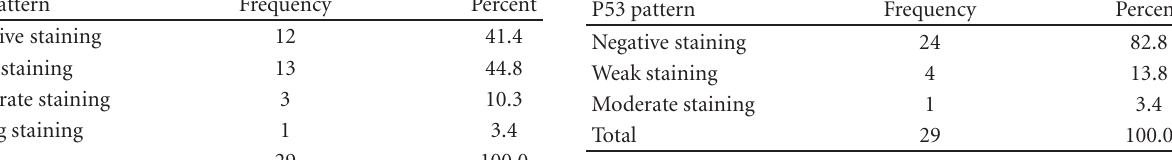
∗ Metastasis to lymph nodes at the time of tumor resection.